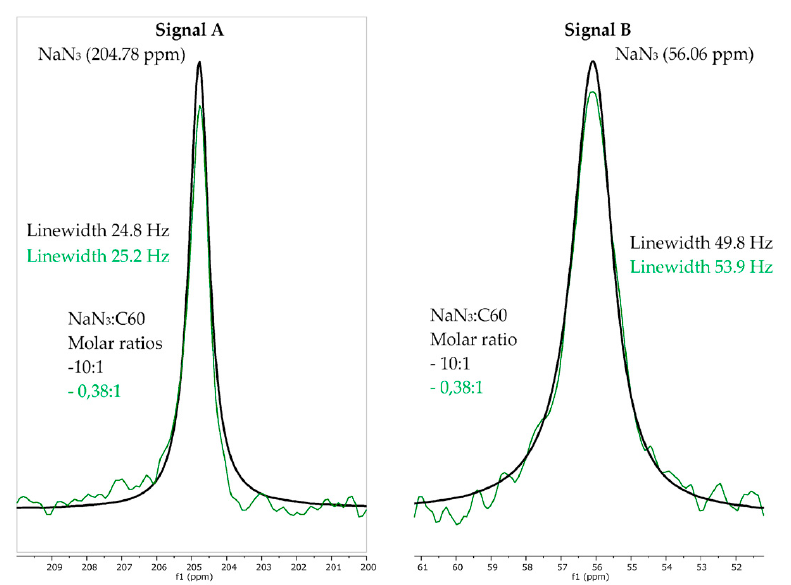
Figure 2. At low molar ratio NaN 3 :C60 ( ≤ 10:1), 14 N chemical shifts are observed for two peaks of NaN 3 (Signals A and B ).